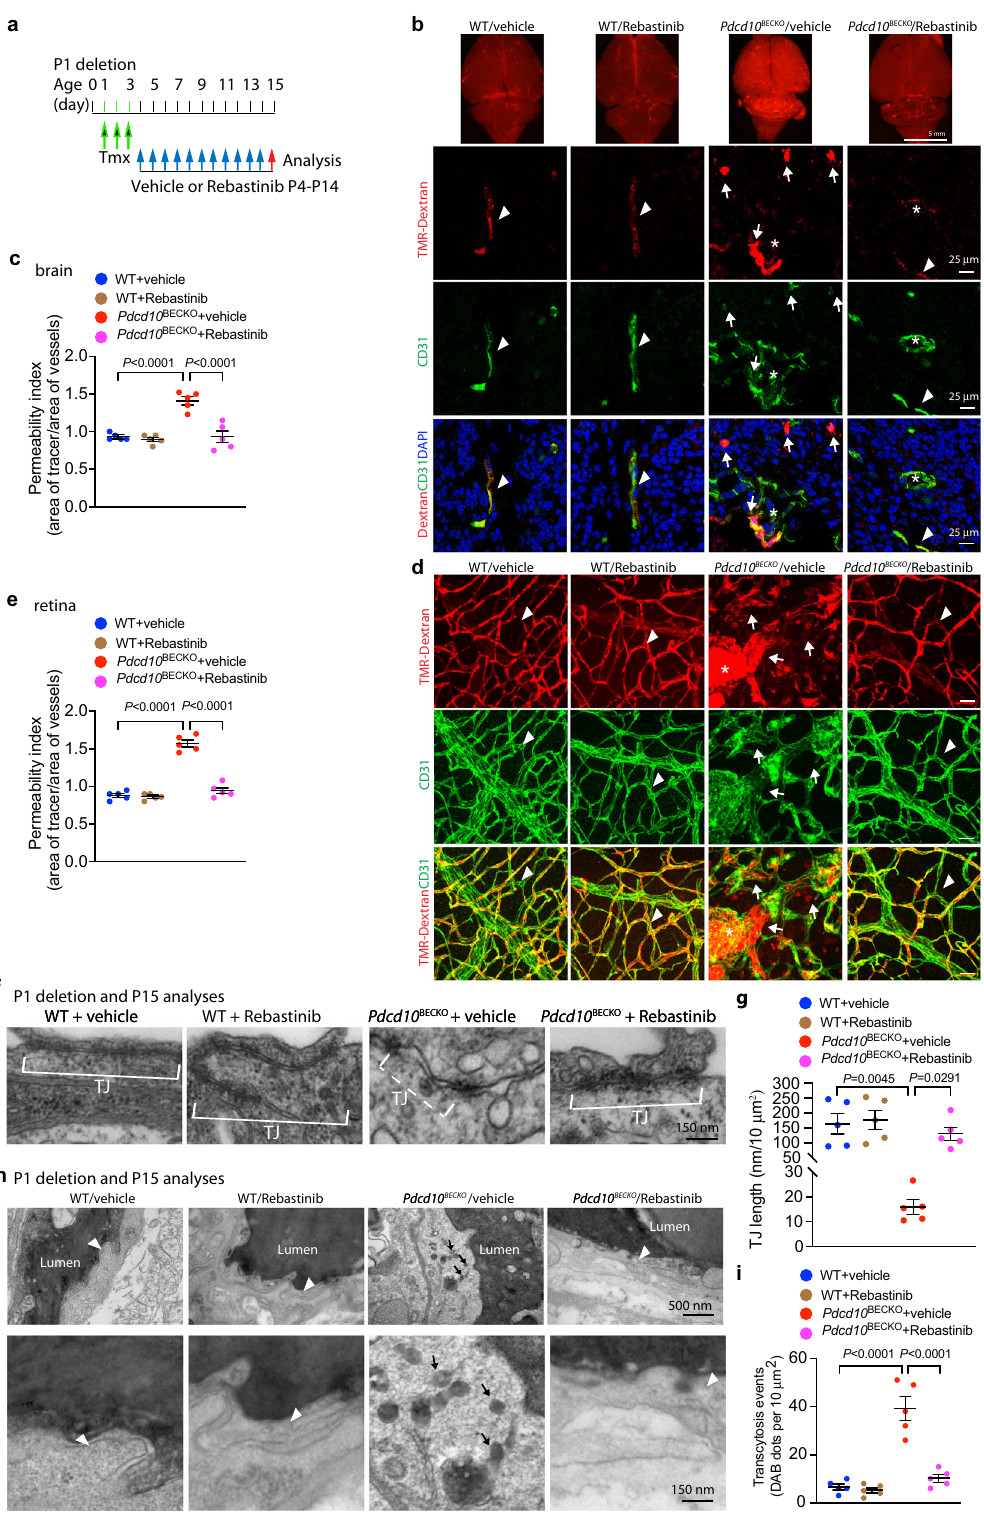
AlexaFlour 488, 555, or 647 (1:400; Invitrogen) or with FITC, Cy3, or Cy5 (1:400; Jackson Laboratories). Immunoblotting . Tissue or cells were lysed in 2x Laemmli buffer and boiled for 5 min at 100 °C followed by centrifugation at 20,000 × g for 15 min at 4 °C. The protein extracts were subjected to standard Western blot analysis which was per- formed. The following antibodies were used for western blotting: Rabbit